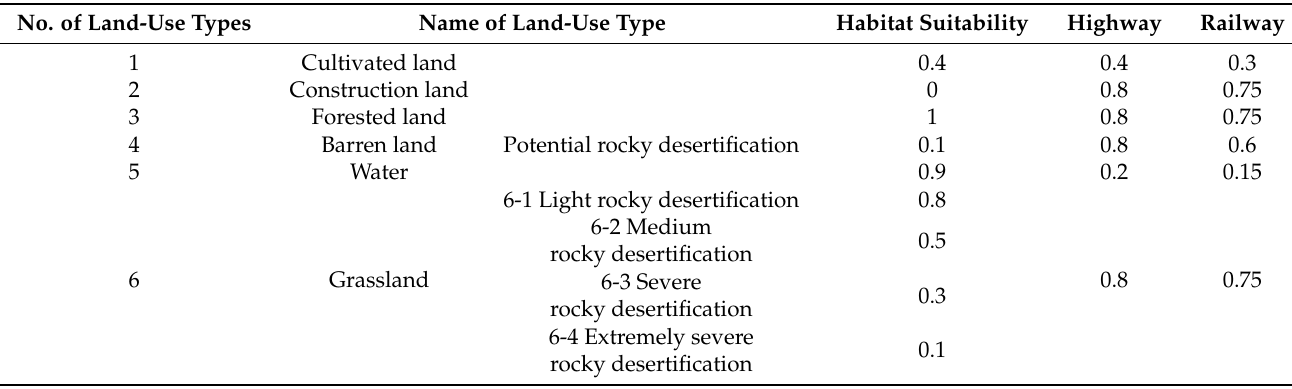
Table 4. Sensitivity of habitat types to